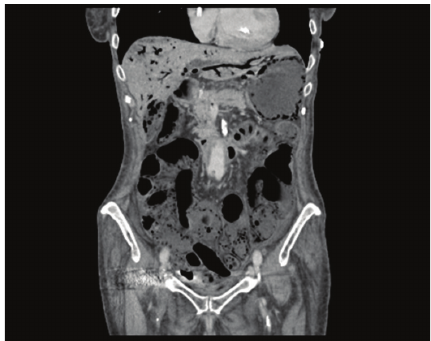
Figure 5: CT showing extensive hepatic portal venous gas, gas within the stomach wall and its draining veins, the gallbladder, common bile duct, and within the majority of the walls of the small bowel (Case 2).